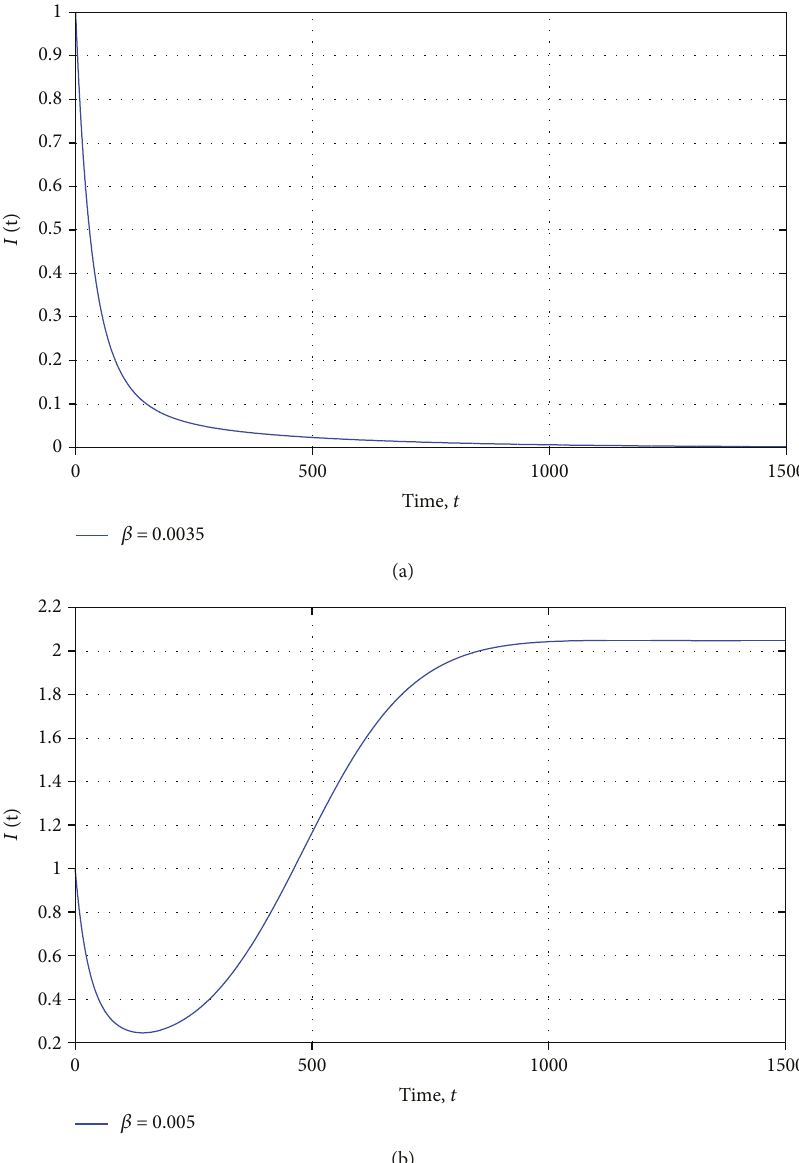
Figure 1: The evolution of the density of the infected I t with parameters listed in text. (a) β = 0 00035 and R and ℛ 0 ≈ 1 3016